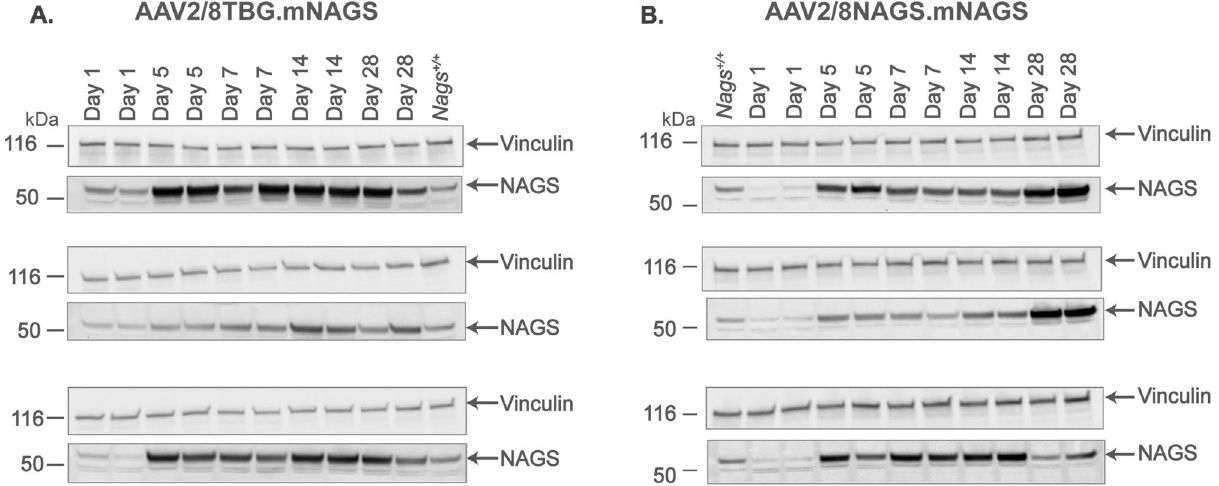
Figure 4. NAGS protein in the livers of Nags −/− mice injected with increasing doses of either AAV2/8TBG. mNAGS ( A ) or AAV2/8NAGS.mNAGS ( B ) vector. AAV2/8TBGnull (Null) vector was injected as a control. Vinculin was used as a loading control. Full-length immunoblots are presented in Supplementary Fig.